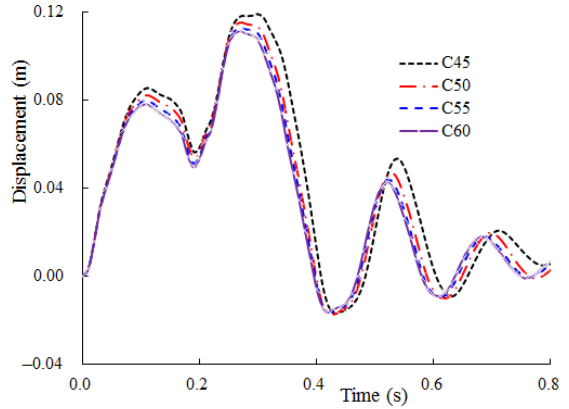
Figure 13. Max displacement time-history of containment.